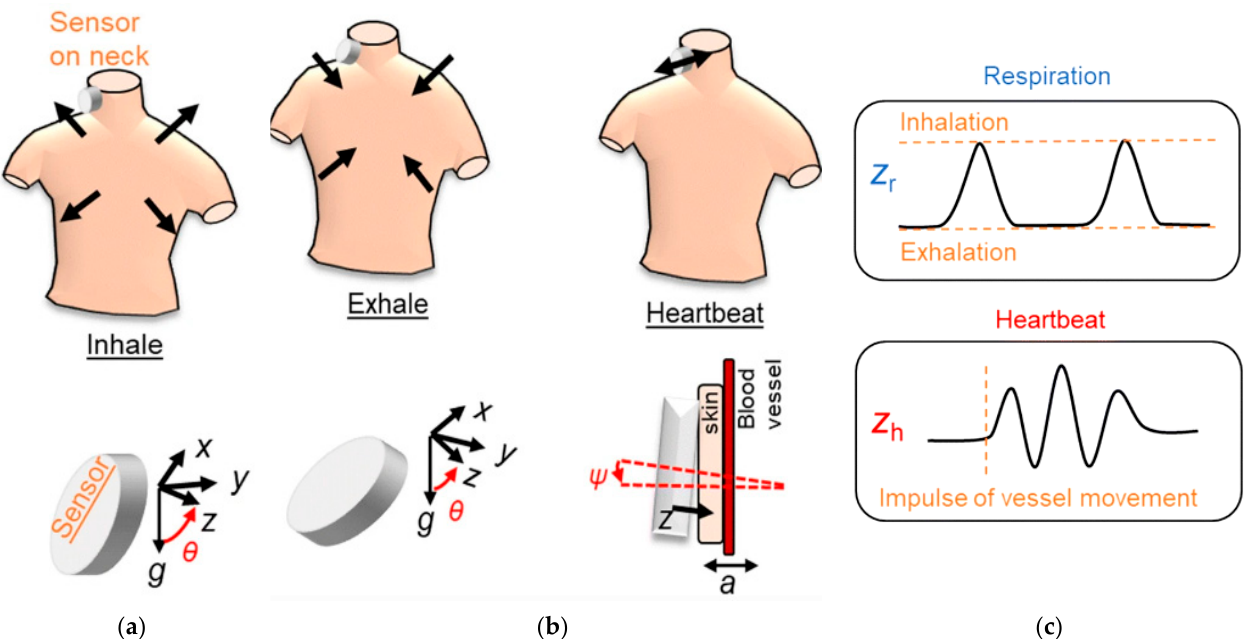
Figure 8. Change of accelerometer axis values during inhalation and exhalation, and position of the axis with respect to the sensor’s surface ( a ); the pulse of the heartbeat generates an acceleration that can be evaluated even if small ( b ); examples of respiratory and cardiac signals ( c ) [114].